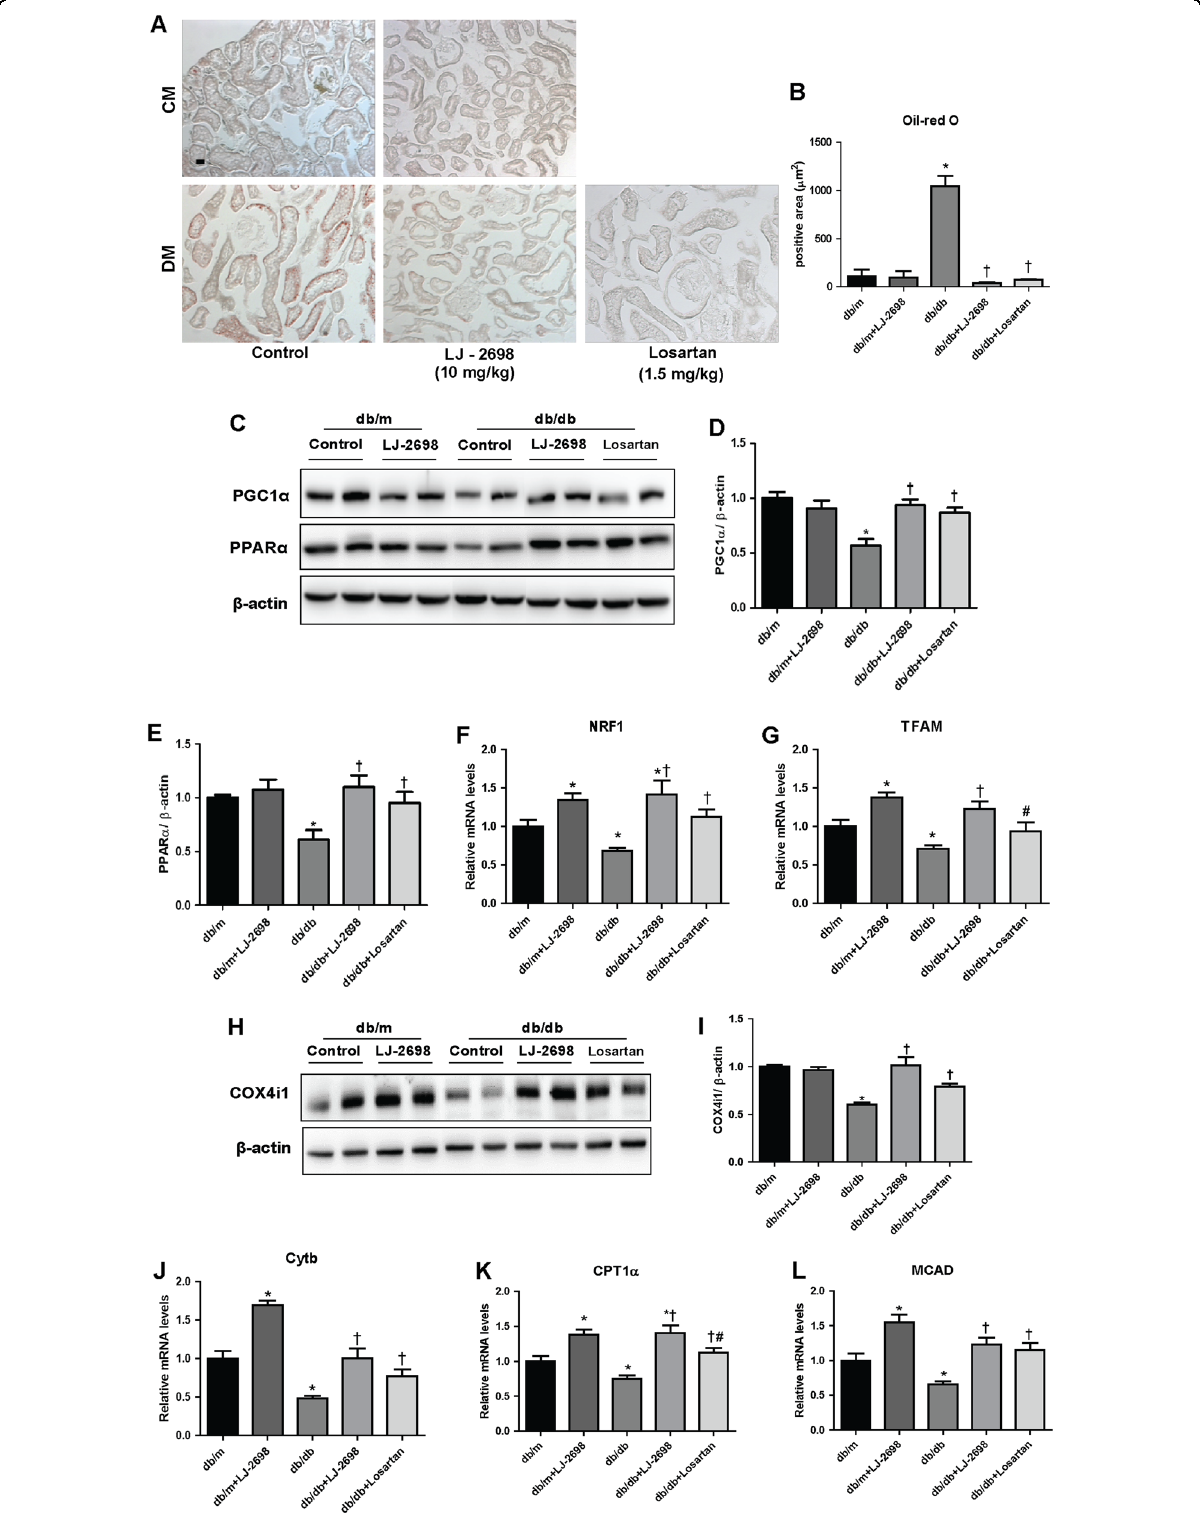
Fig. 8 (See legend on next